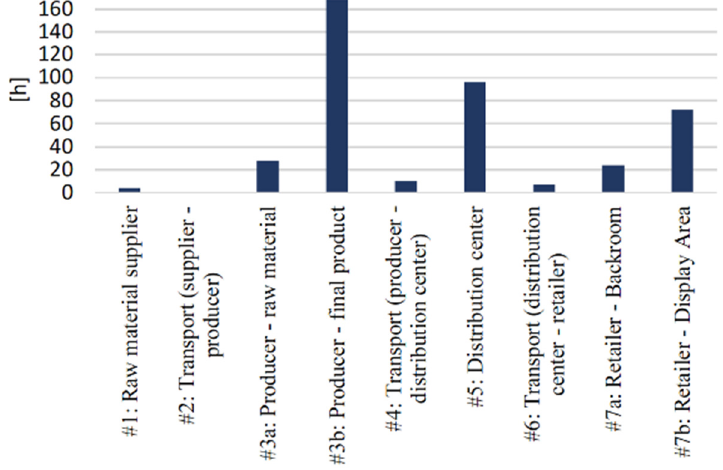
Figure 3. Storage time at each actor of the cold chain.